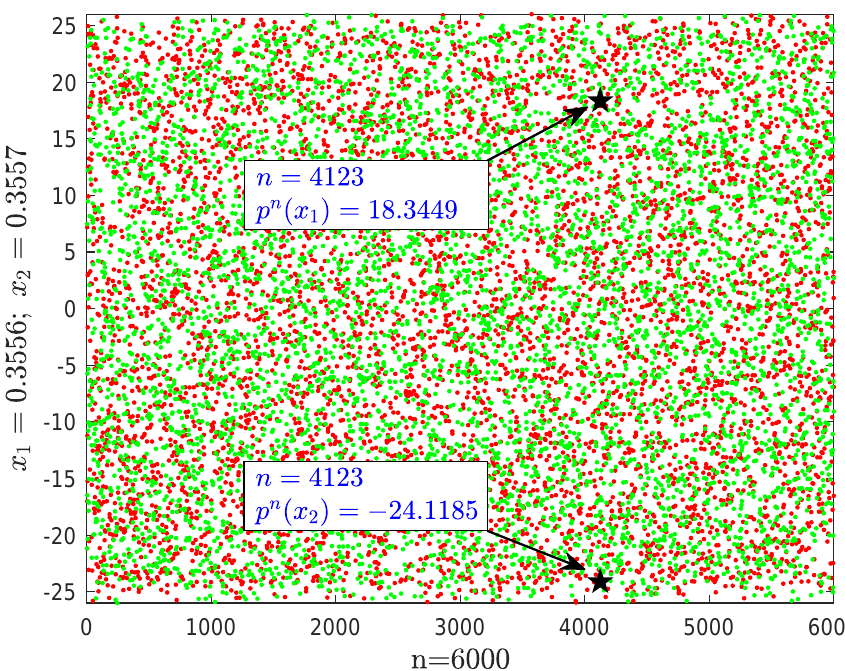
Figure 2. Chaotic behaviors of p in Example 2 with the initial data x 1 = 0.3556, x 2 = 0.3557 and n =